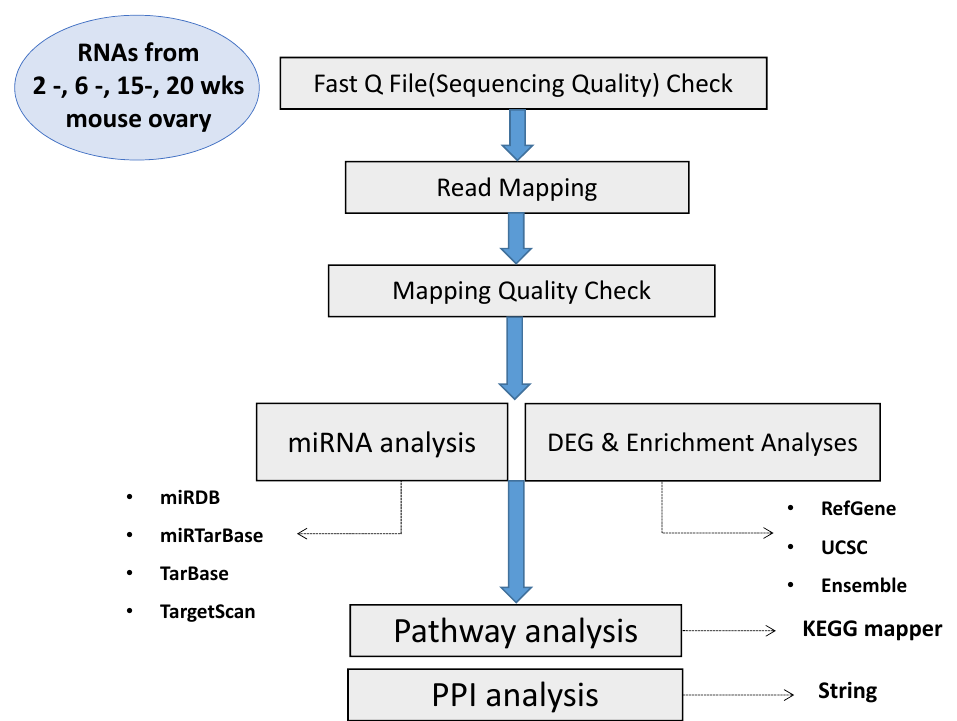
Fig 1. Experimental scheme of this study.